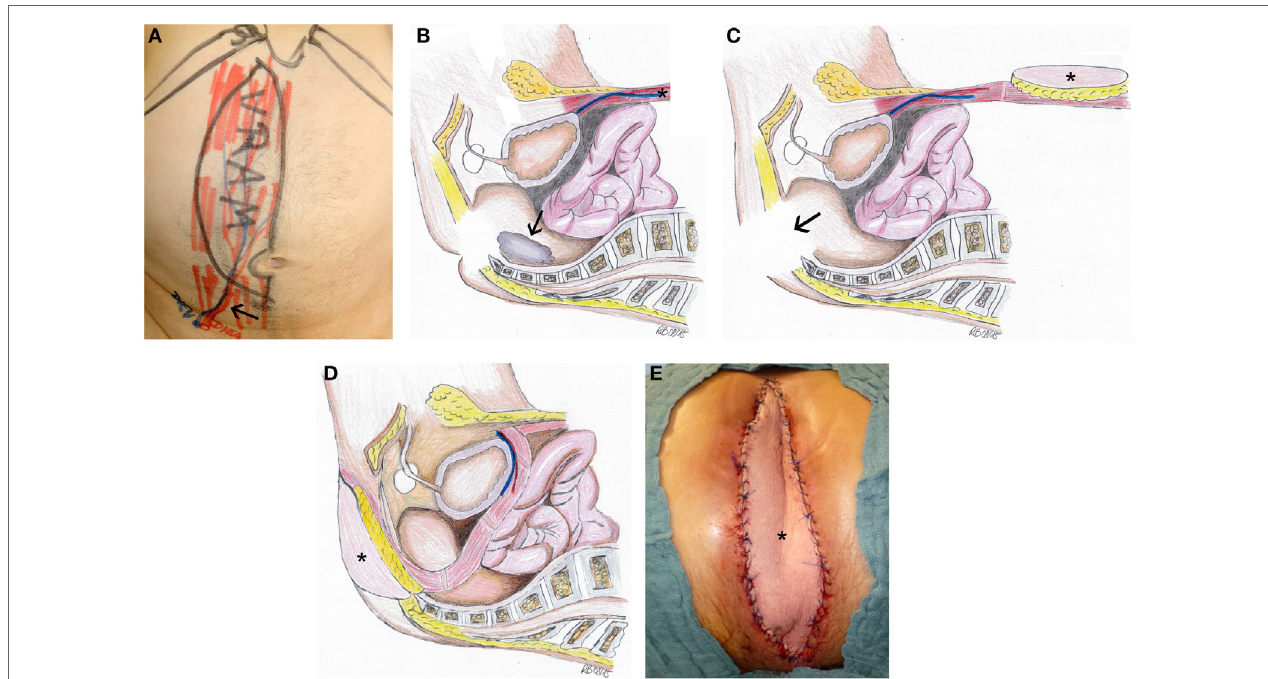
FiGURe 1 | Defect reconstruction after resection of a rectal carcinoma using vRAM flap illustrated by intraoperative photographs and schematic drawings of the surgical technique . (A) Preoperative marking for VRAM-flap procedure with the planned skin paddle and location of the ostomy performed on the day before surgery. Black arrow marks the flap pedicle. (B) The operation involves a two-part procedure with an anterior abdominal dissection first, which is followed by a second step with perineal tumor excision (black arrow) in prone position. We first ensure the viability of the deep inferior epigastric vessels before we proceed with the flap raising. The design of the flap and the size of the skin paddle are then planned according to the prospective perineal and pelvic defect. The skin island is placed vertically over the rectus muscle. The rectus muscle is dissected cranially from the costal arch. In the prone phase, tumor excision (black arrow) had been completed (C) . The flap (black asterisk) is then flipped and rotated at 180° into the pelvic cavity so that the skin paddle closes the defect (D) . Intraoperative view with VRAM flap (black asterisk) inserted to reconstruct perineal defect (e)